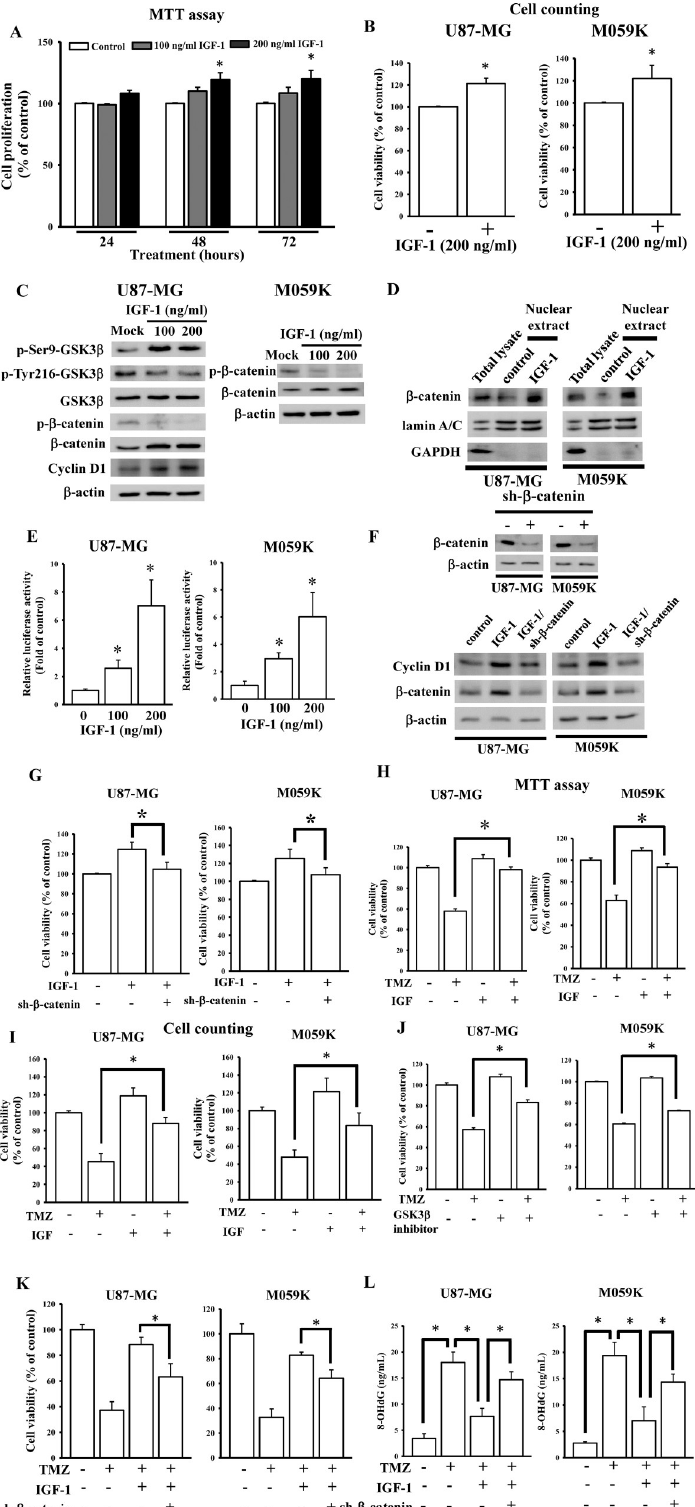
Fig 1. The insulin-like growth factor (IGF)-1-activated WNT/ β -catenin pathway influences glioma cell sensitivity to temozolomide (TMZ). (A and B) Effects of IGF-1 on cell proliferation. U87 MG cells were treated with